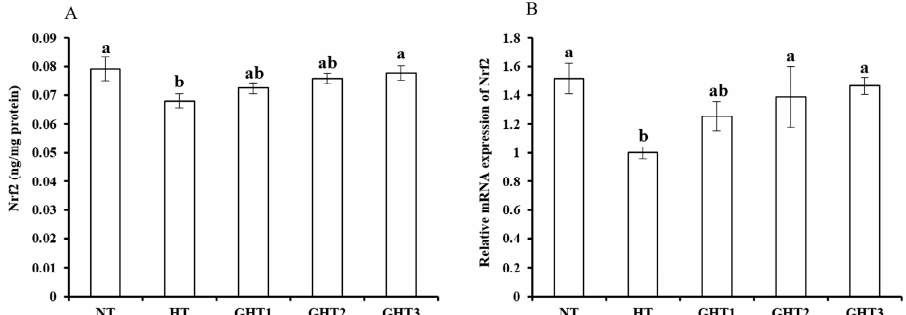
Figure 5. Effect of Gln on Nrf2 protein ( A ) and gene ( B ) expression in the liver of broiler exposed to high temperature conditions. Different lowercase letters above each column indicate significant ( p < 0.05) differences among the groups. NT group: Broilers were kept in the normal temperature environment and fed a basal diet. HT, GHT1, GHT2, and GHT3 groups: Broilers in these groups were kept in high temperature conditions and fed a basal diet supplemented with 0%, 0.5%, 1.0%, and 1.5% Gln.